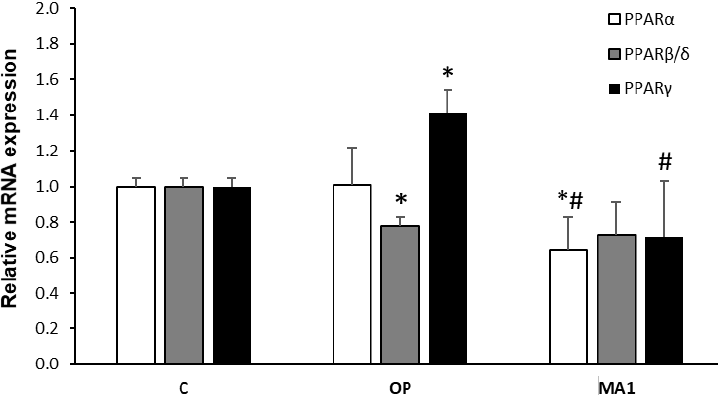
Figure 4. Effects of MA1 on PPAR expression in steatotic FaO cells. Relative expression of PPAR isoforms as evaluated by real-time PCR. Steatotic FaO cells (OP) were then incubated for 24 h in the presence of 10 µ g/mL MA1. Data are mean ± SD of three independent experiments and are expressed with respect to controls. Significant differences are denoted by symbols on bars (* p ≤ 0.05 vs. control; # p ≤ 0.05 vs. OP).